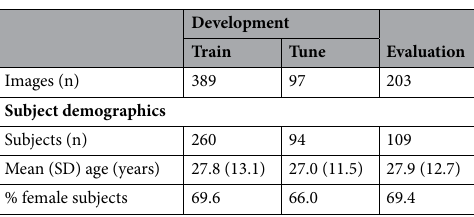
Table 1. Subject demographics of the meibography image dataset used in the study.